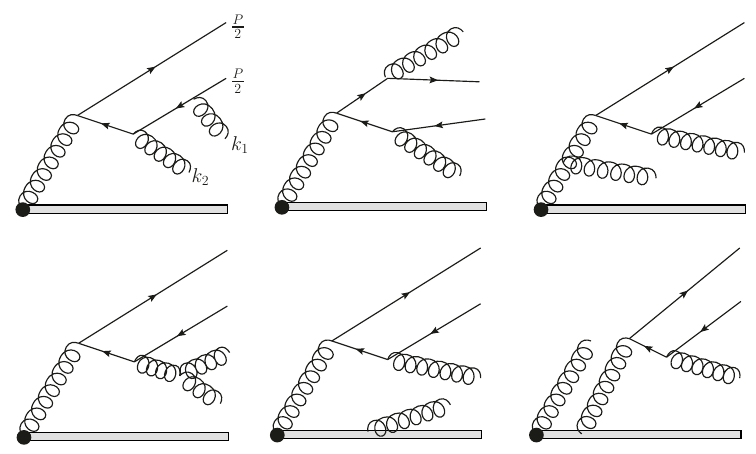
) + gg . The other diagrams can be 0